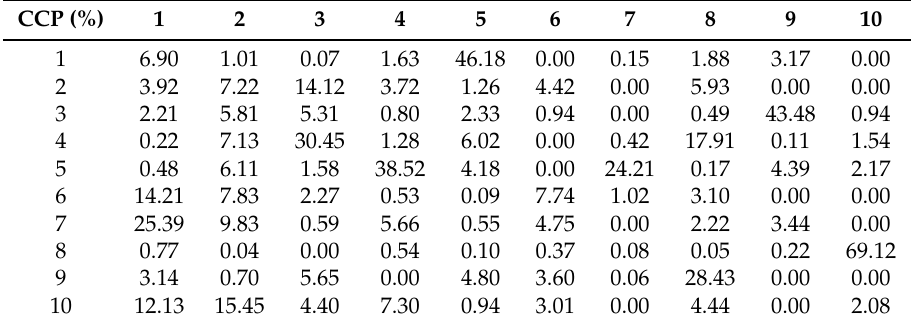
Table A4. The SOR value for the embedding representation between the resting state of the HCP dataset and the AR group in the sleep-deprivation condition.